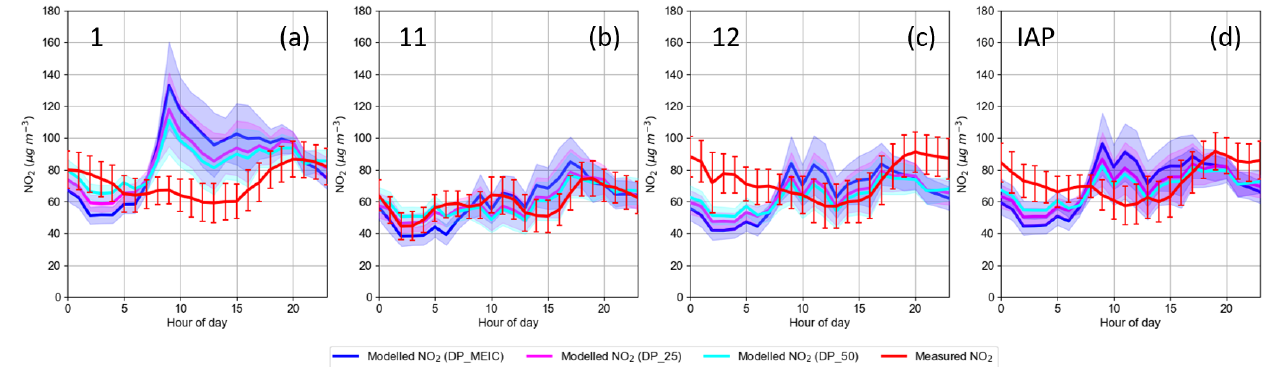
Figure 18. Campaign period mean diurnal variation in measured and modelled NO 2 concentrations using MEIC Opt at sites (a) 1, (b) 11, (c) 12, and (d) IAP. Measurements marked by red line. Shaded areas and error bars represent the 95% confidence intervals for simulated and measured concentrations, respectively.